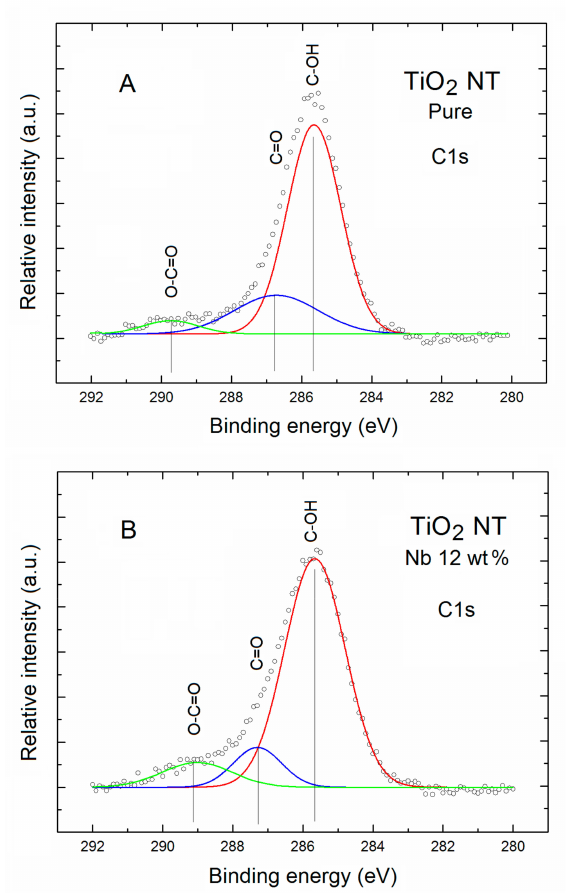
Figure 4. XPS C1s spectral lines of ( A ) pure and ( B ) Nb-doped TNT after the Gauss deconvolution. The circles correspond to the experimental curves after linear smoothing, whereas the color lines correspond to the respective deconvoluted